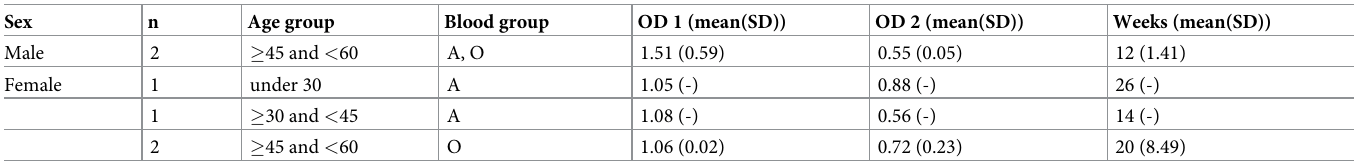
Table 2. Characteristics of donors loosing anti SARS-CoV-2